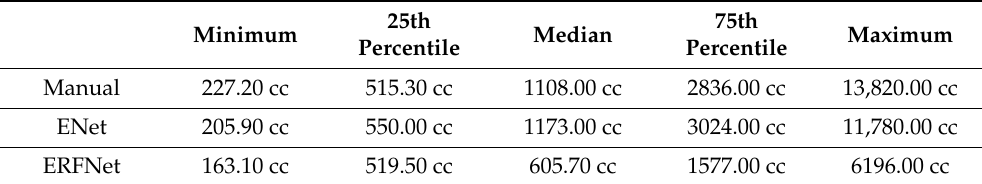
Table 1. Reference values of manually and automatically segmented RPS volumes from CT examina- tions in cubic centimeters (cc).